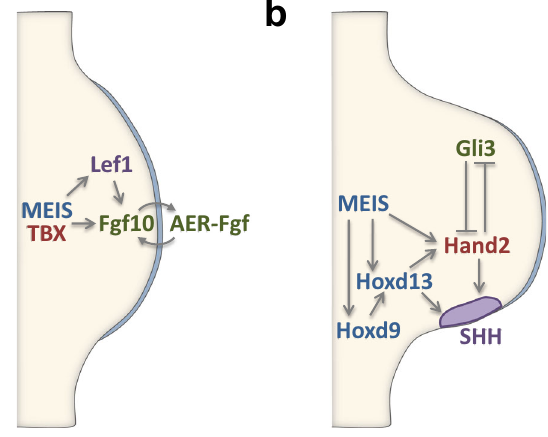
Fig. 8 Proposed role of Meis in limb initiation and AP prepatterning. During limb initiation ( a ), Meis is required in parallel to Tbx factors for activation of the Wnt target Lef1 and Fgf10 , both essential for limb-bud formation and progression. This function is similar in FLs and HLs. During AP patterning in the FL ( b ), Meis is required directly or indirectly for the activation of various prepatterning genes, like Hoxd9 , Hoxd13 , and Hand2 , all involved in Shh regulation leads to Shh posterior activation and reciprocal Gli3 expression, establishing AP limb patterning (Fig. 8b). While the outcome of Meis elimination is similar in the HL — failure to activate Shh — the speci fi c regulatory interaction in the HL is different and will require further study.